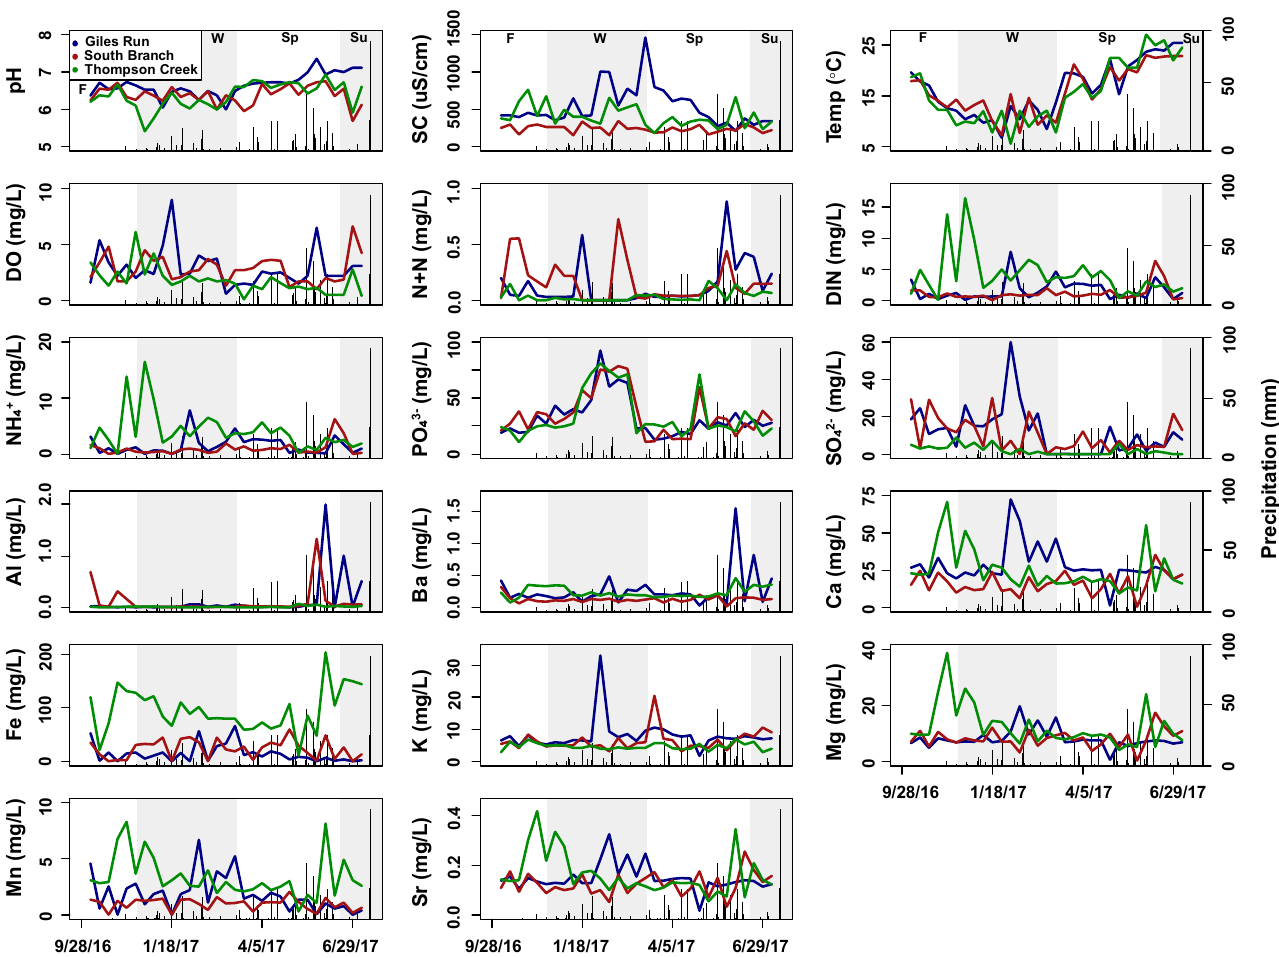
Figure 3. Time series plots of measured subsurface water variables for Giles Run (blue), South Branch (red), and Thompson Creek (green) from September 2016 to July 2017. Alternating grey and white bars indicate the seasons: summer (Su), fall (F), winter (W), and spring (Sp). Black bars indicate daily precipitation.